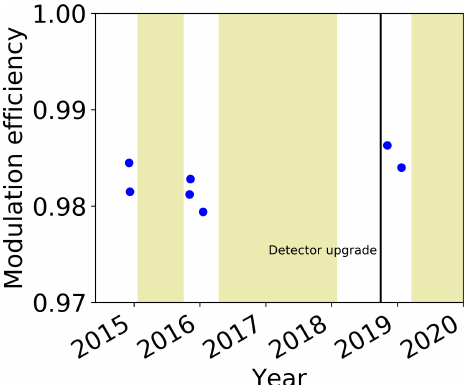
Figure 3. Time series of the modulation efficiency at MOPD of the EM27/SUN used in this study. ILS measurements were performed during periods when the instrument was in Karlsruhe for mainte- nance or detector upgrade. Yellow areas denote measurement pe- riods in Gobabeb. The black bar denotes the time of the detector